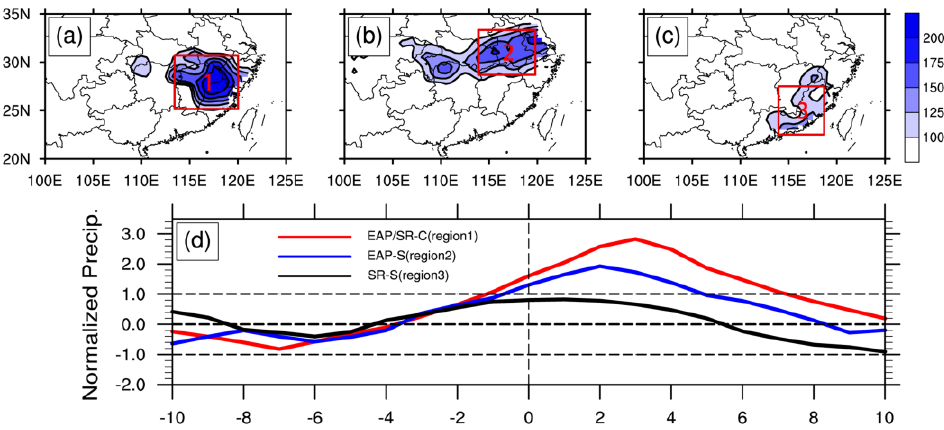
Figure 2. Spatial distributions of total accumulated precipitation (units: mm) in Southern China of ( a ) EAP/SR-C; ( b ) EAP-S; and ( c ) SR-S events; ( d ) Daily normalized domain-averaged precipitation in the region-1 (114–120° E, 25–30° N, red line for EAP/SR-C events), region-2 (114–120° E, 28–33° N, blue line for EAP-S events), and region-3 (114–118° E, 22.5–27.5° N, black line for SR-S events) from day −10 to day 10. The numbers of X -coordinate in Figure 2d represent the same meaning of that in Figure 1.